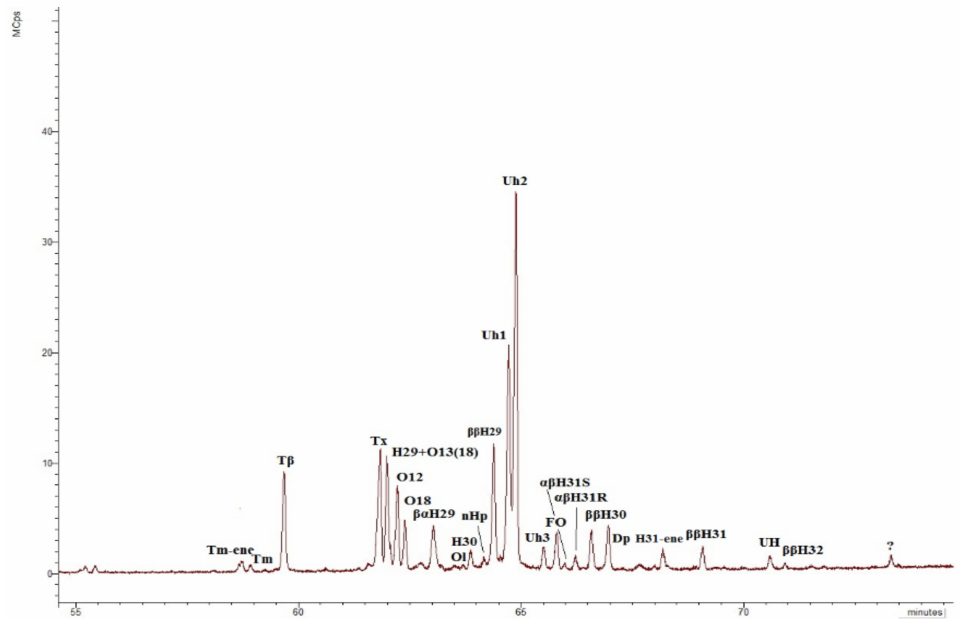
Figure 10. Chromatogram m/z 191 of the aliphatic fraction of the sediment sample collected at the cliff level of 20 m. Tm-ene—17 α (H)-22,29,30-tris-norhop-(17,21)-ene; Tm—17 α (H)-22,29,30- trisnorhopane; T β —17 β (H)-22,29,30-trisnorhopane; Tx –taraxerene (D:A-Friedolean-14-ene);